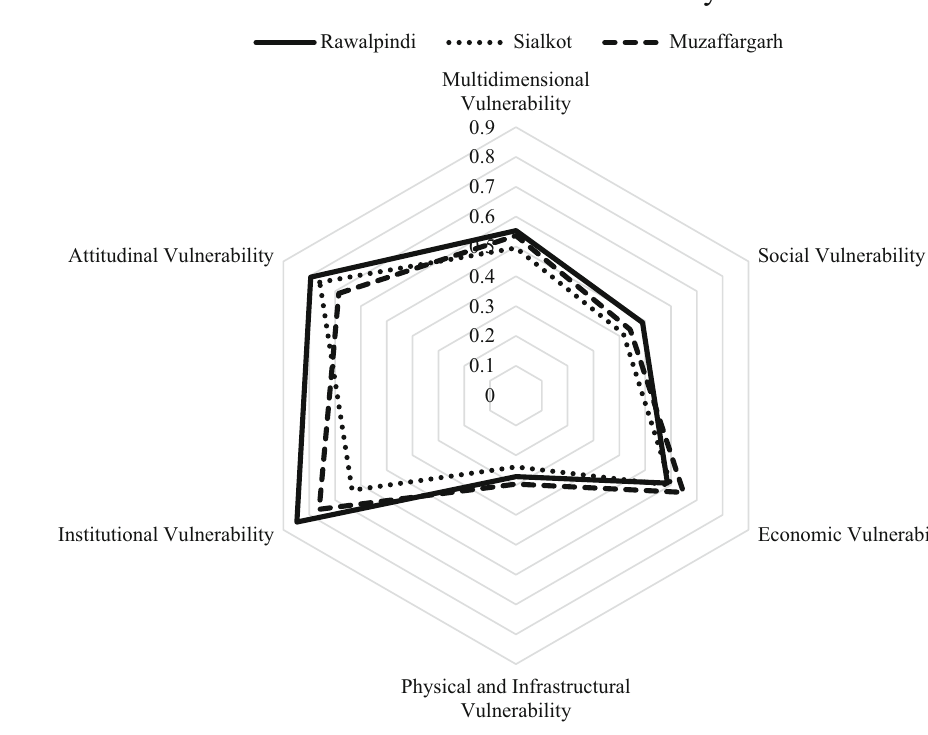
Fig. 2 Multidimensional vulnerability to urban flooding in Dhok Ratta